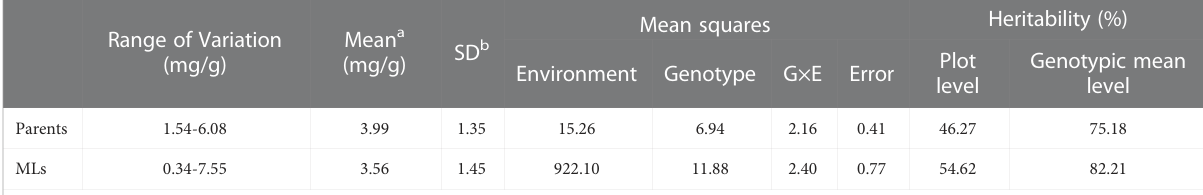
TABLE 1 Phenotypic variations, variance components and heritability for nicotine content in tobacco MAGIC population in 3 environments.